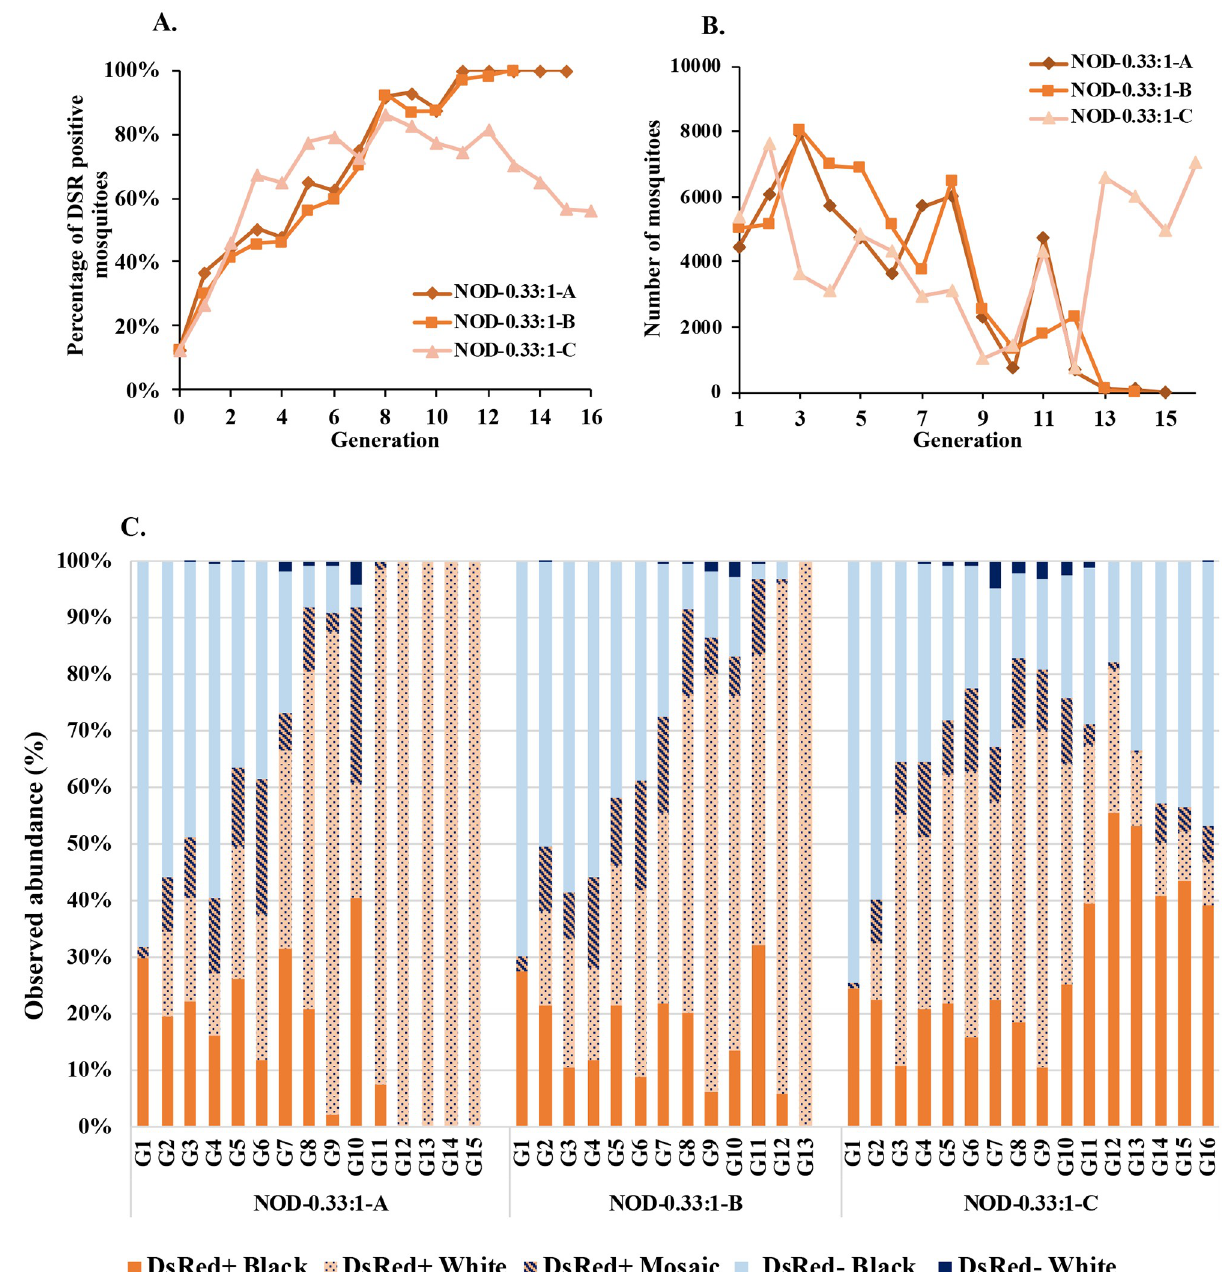
Fig 4. Non-overlapping gene drive (NOD) cage trial with initial releases of 0.33:1 transgenic AsMCRkh2 to wild-type males. Three cages (NOD- 0.33:1A, NOD-0.33:1B and NOD-0.33:1) were seeded initially with 100 wild-type female, 75 wild-type male and 25 AsMCRkh2 male pupae. The resulting next generation larvae, pupae and adults were scored as DsRed-positive (DsRed + , carrying the AsMCRkh2 gene drive cassette) or wild-type. (A) Percentages of DsRed-positive (DsRed + ) adult mosquitoes (Y-axis) in the total population in each cage scored at each generation (X-axis). (B) Total population size (Y-axis) in each replica cage at each generation (X-axis). (C) Abundance in percentages (Y-axis) of eye color and DsRed phenotypes of ~500 randomly-selected pupae per generation in each cage.